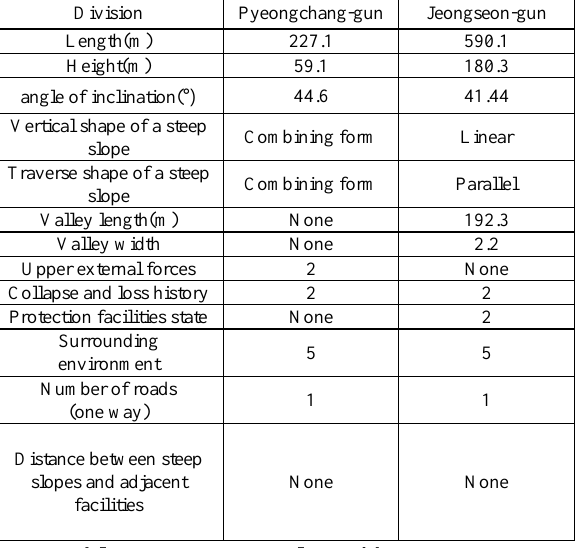
Figure 7. Jeongseon-gun steep slope falling rock prevention and rock